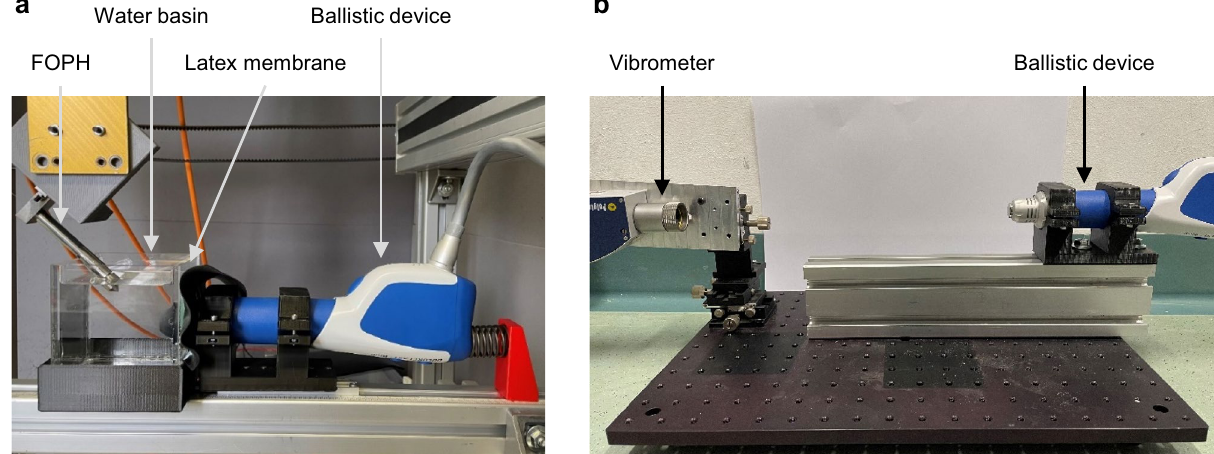
Figure 1. Test setups. ( a ) Pressure measurements. ( b ) Vibrometer